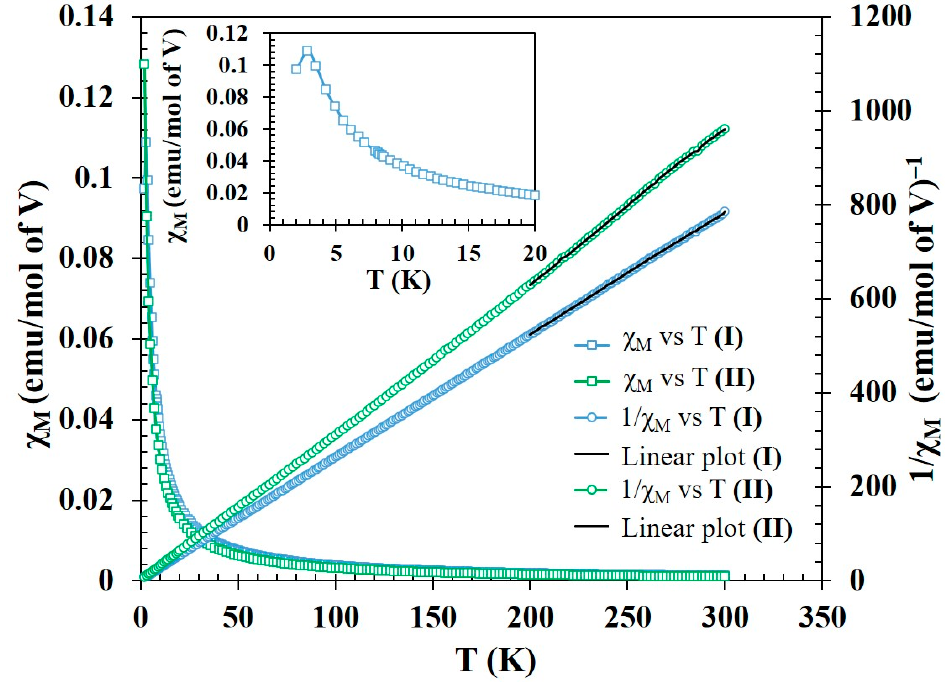
Figure 5. Temperature dependence of molar magnetic susceptibility ( χ M ) and inverse molar magnetic susceptibility ( χ M–1 ) of Li 2 VO 0.55 (H 2 O) 0.45 F 5 · 2H 2 O ( I ) and Li 3 VOF 5 (II) . (The inset shows the onset of anti-ferromagnetic ordering in II ).